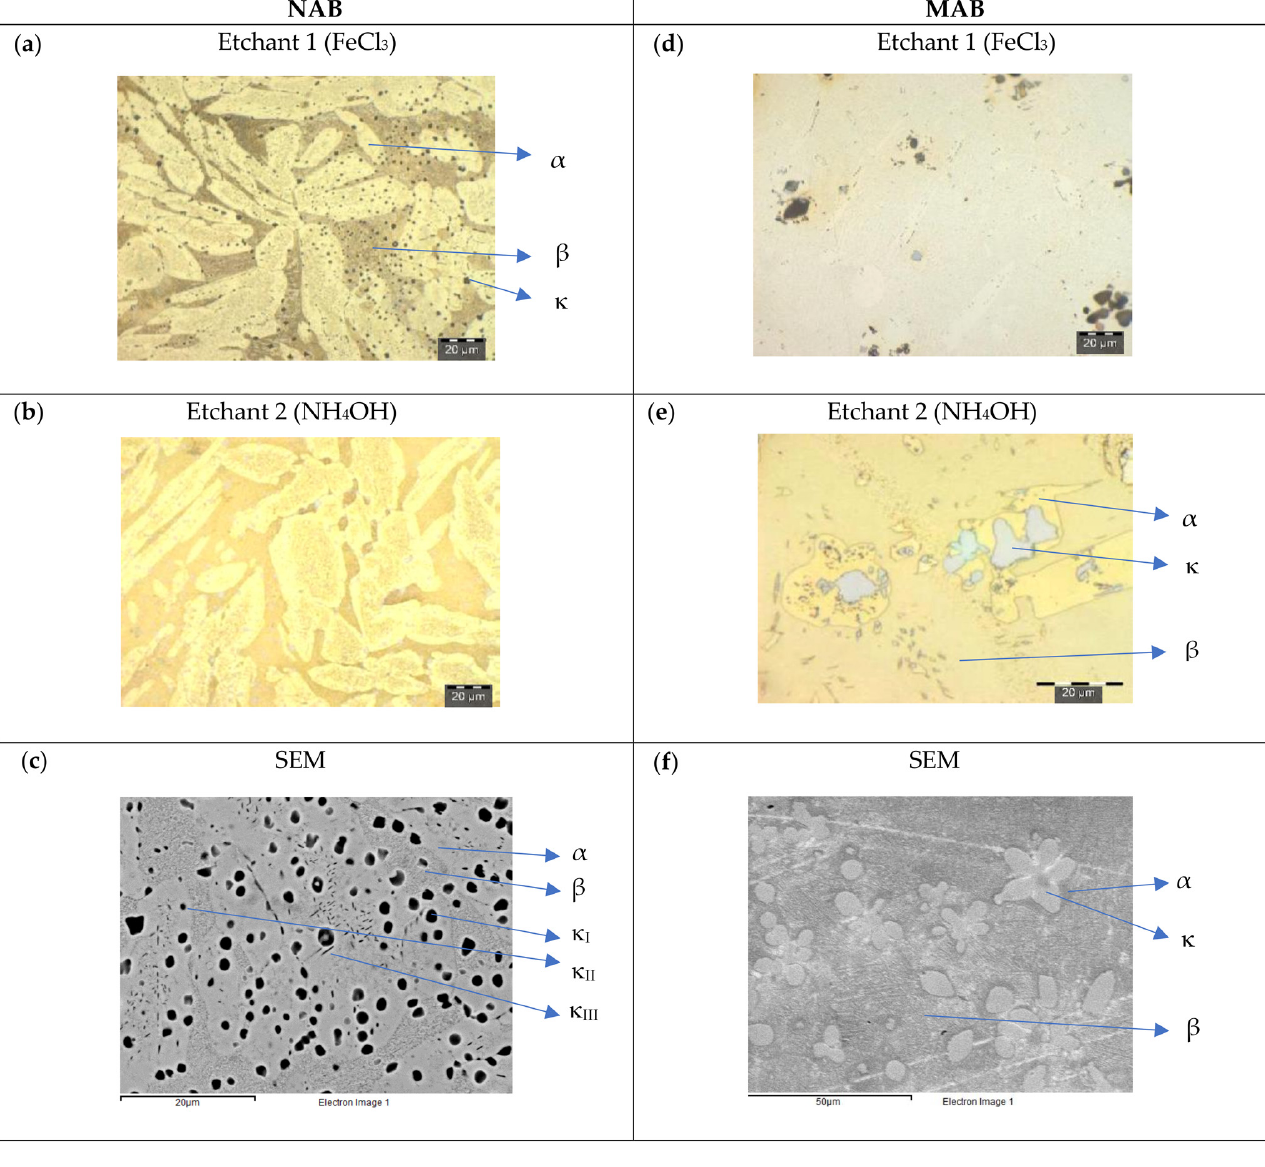
Figure 6. NAB and MAB microstructure after quenching and tempering (T2). LOM images after applying etchants 1 ( a , d ) and 2 ( b , e ), and SEM-BSE pictures ( c , f ). On NAB, the α -phase is clearly found in the microstructure after the heat treatments of quenching (T1), quenching and tempering (T2) and in the as-cast state (AR). The β -phase is retained after T1 but is transformed after T2 and acquires a similar morphology to that observed in AR. After the heat treatments, an increase in the quantity and size of the κ -phases has been observed. On MAB, α - and β -phase configure a large percentage of the microstructure. The dendrites of α -phase are larger in relation to those found in NAB. After T1, β -phase in- creases its presence and there is a notable growth in size of the rosette-shaped precipitates that define the κ -phases and which are distributed in α -phase. Finally, after T2, the rosette precipitates lost their shape accompanied by coarsening.